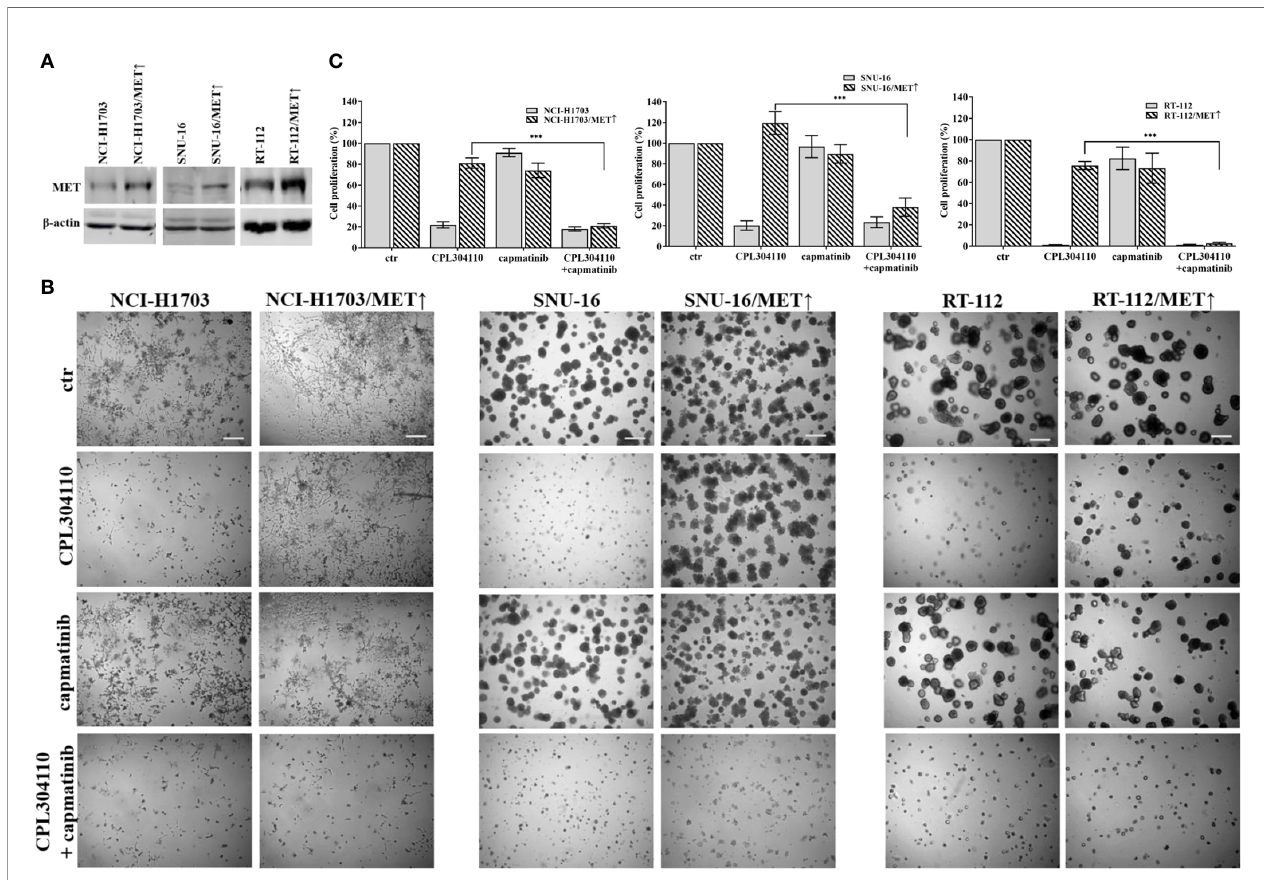
FIGURE 4 | MET overexpression impairs sensitivity to FGFR inhibitor. (A) NCI-H1703, SNU-16, RT-112 cells with overexpression of MET were established as described in the materials and methods section. (B) NCI-H1703, SNU-16, RT-112 cells, and their variants with MET stable overexpression were grown in 3D Matrigel ® for 14 days in the presence of CPL304110 (1 m M) and/or HGF (50 ng/ml). Representative pictures were taken. Scale bar represents 100 m m, n = 3. (C) Cell proliferation of either parental or MET-overexpressing cells was assessed using the MTT assay after exposure to CPL304110 (1 m M) and/or capmatinib (5 m M) for 96 h. Data are expressed as mean ± SD, ***p ≤ 0.001, n =